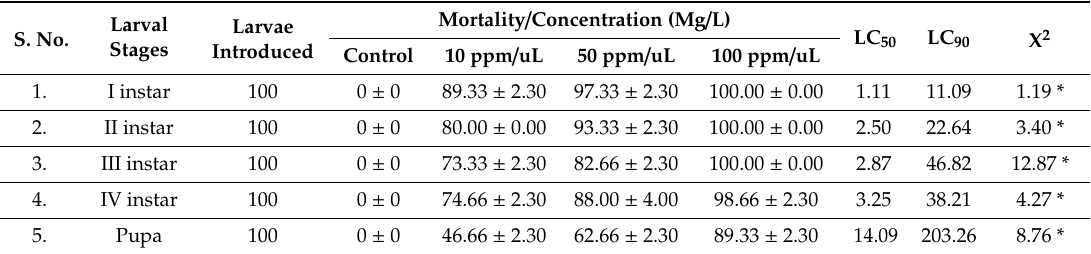
The antibacterial activity of selenium nanoparticles synthesized using D. indica leaf extract was investigated against the human pathogen, St. aureus (MTCC 96) and Se. marcescens (MTCC 4822) by well di ff usion method (Table S3). The antibacterial activity of the synthesized selenium nanoparticles in 25, 50, 75 and 100 µ L concentrations were quantitatively measured by the formation of zones of inhibition. Selenium nanoparticles synthesized using D. indica leaf extract developed inhibitory zones measuring 0.50, 0.63, 0.75 and 1.03 cm in diameter on the live culture plates of St. aureus (MTCC 96) after 24 h of treatment with 25, 50, 75 and 100 µ L concentrations respectively (Figure 4). In another experiment the inhibitory zones measured 0.47, 0.66, 0.76 and 1.08 cm diameter on the live culture plates of Se. marcescens (MTCC 4822) when treated with 25, 50, 75 and 100 µ L concentrations of selenium nanoparticles respectively (Figure 5).